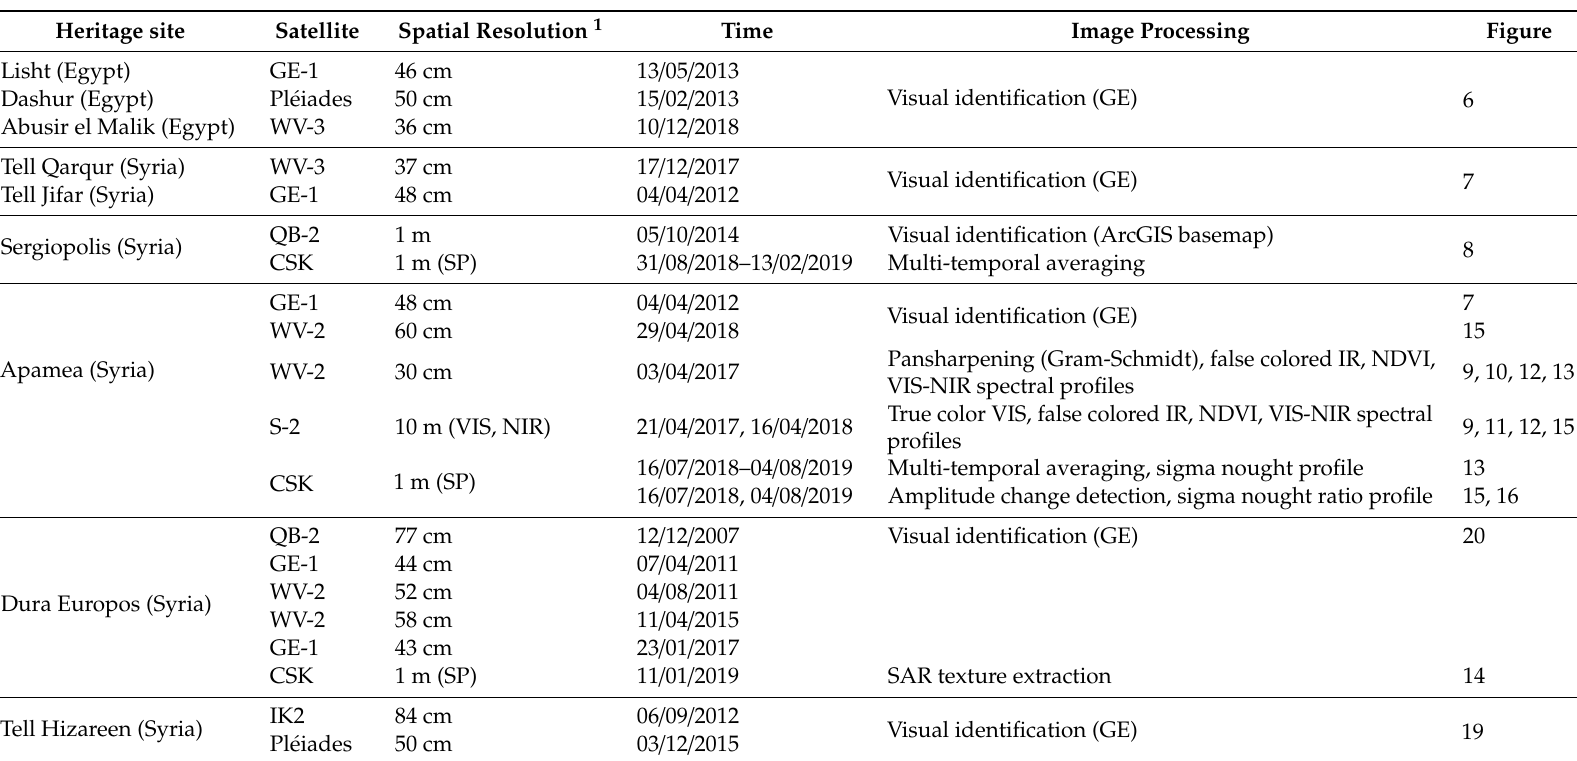
Table 2. Summary of looted heritage sites presented in this paper for demonstration and discussion purposes, satellite imagery used and image processing technique applied. Notation: CSK—COSMO-SkyMed; GE—Google Earth; GE-1—GeoEye-1; GSD—ground sample distance; IK2—IKONOS-2; IR—Infrared; NIR—Near-Infrared; NDVI—Normalized Di ff erence Vegetation Index; PS—pansharpened; QB-2—QuickBird-2; S2—Sentinel-2; SP—Spotlight Enhanced